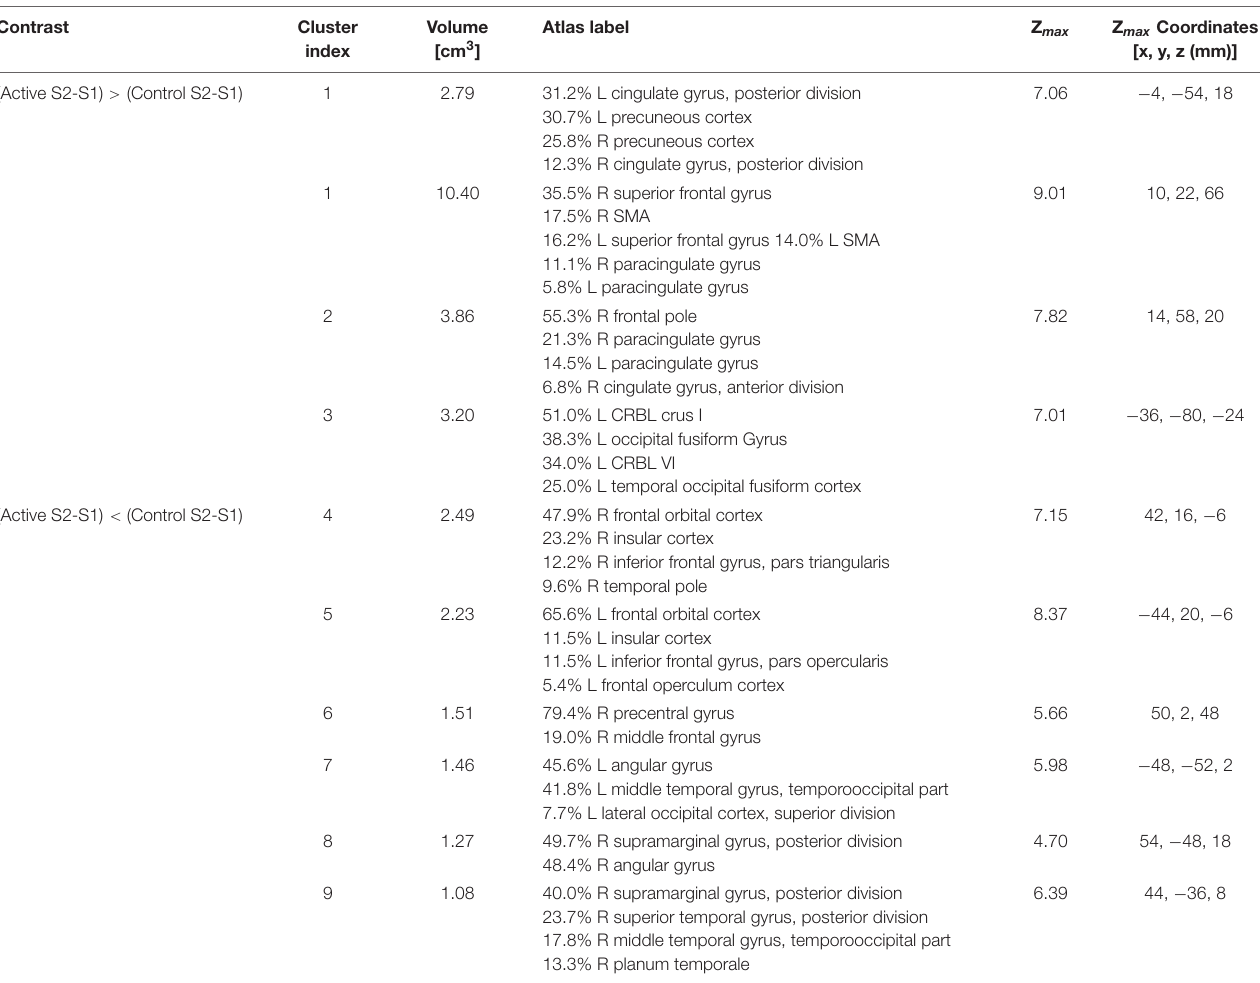
TABLE 2 | Significant group-by-time interaction – Post hoc analysis. Contrast Cluster